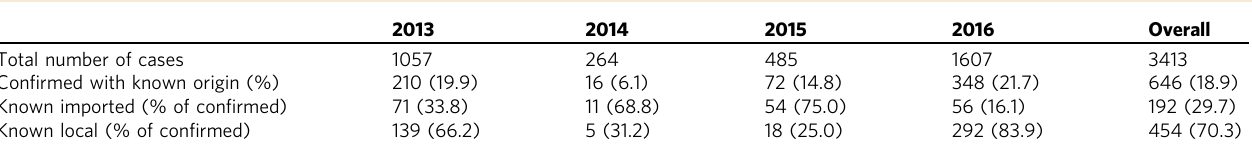
Table 1 Characteristics of observed dengue